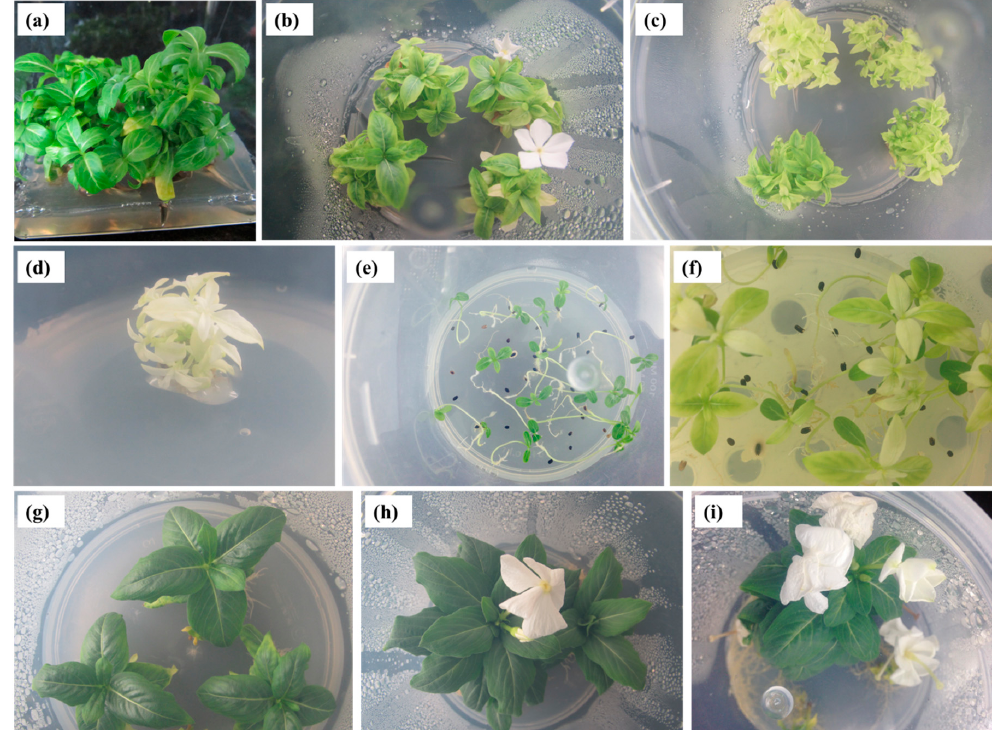
Figure 1. In vitro propagation of Catharanthus roseus . ( a ) Multiple shoots produced from nodal segments of C. roseus cultivated on MS medium with 2 µM TDZ and 1 µM NAA after 45 days; ( b ) in vitro flowers produced from the multiple shoots regenerated on MS medium with 2 µM TDZ, 1 µM NAA and 5% sucrose; ( c ) somaclonal variation in C. roseus ; ( d ) multiple albino (variant) shoots produced from nodal segments isolated from the variant shoot cultivated on MS medium with 2 µM TDZ and 1 µM NAA; ( e ) seeds obtained from normal green plantlets were germinated on MS nutrient medium; ( f ) seeds obtained from somaclonal variant plantlets were germinated on MS nutrient medium; ( g ) root induction from a shoot cultivated on half-strength MS medium with 4 µM IBA; in vitro flowers produced from the rooted shoot cultivated on half-strength MS medium with 4 µM IBA plus ( h ) 3% sucrose and ( i ) 5% sucrose.